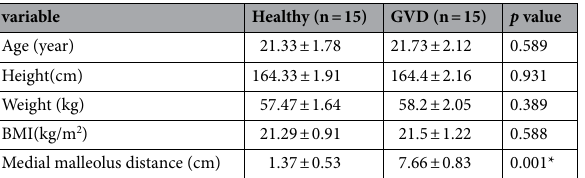
Table 1. Demographic characteristics of the participants (Mean ± SD). *Significant in p ≤ 0.05 level. GVD Genu valgum deformity.